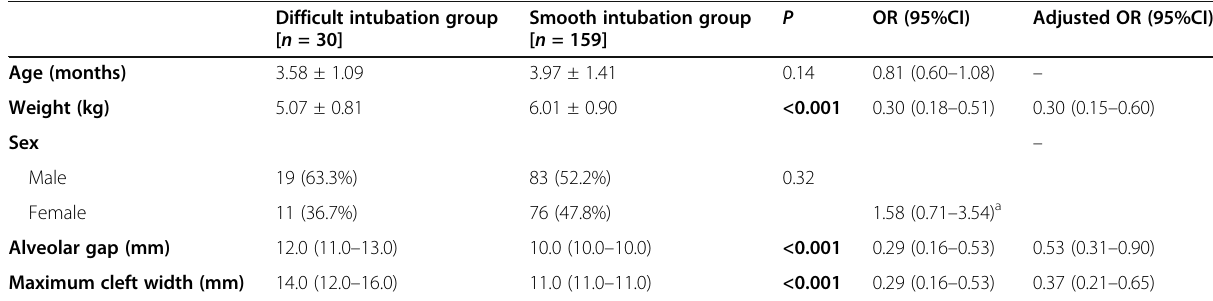
Table 2 Comparison between the study groups regarding demographic and clinical characteristics and their association with difficulty of intubation